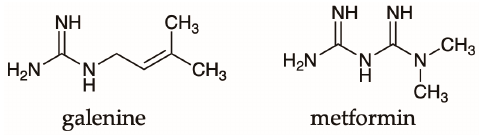
Figure 1. Chemical structure of galegine and metformin.